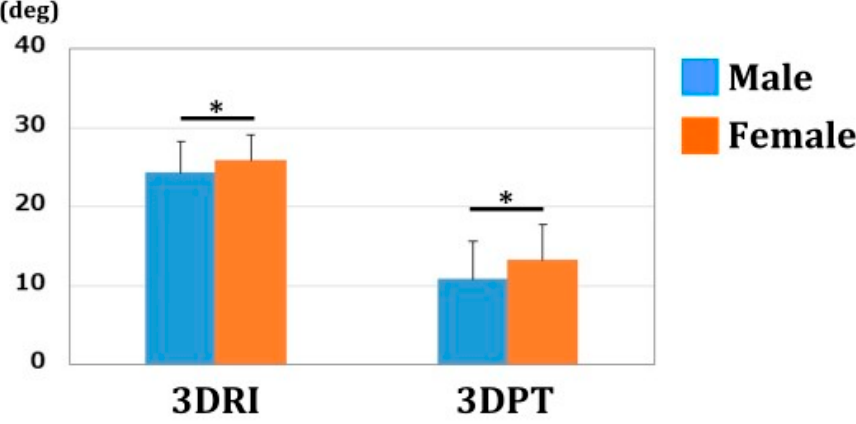
Figure 6. 3DRI and 3DPT. Both 3DRI and 3DPT were significantly larger in females than in males (*: p < 0.01).